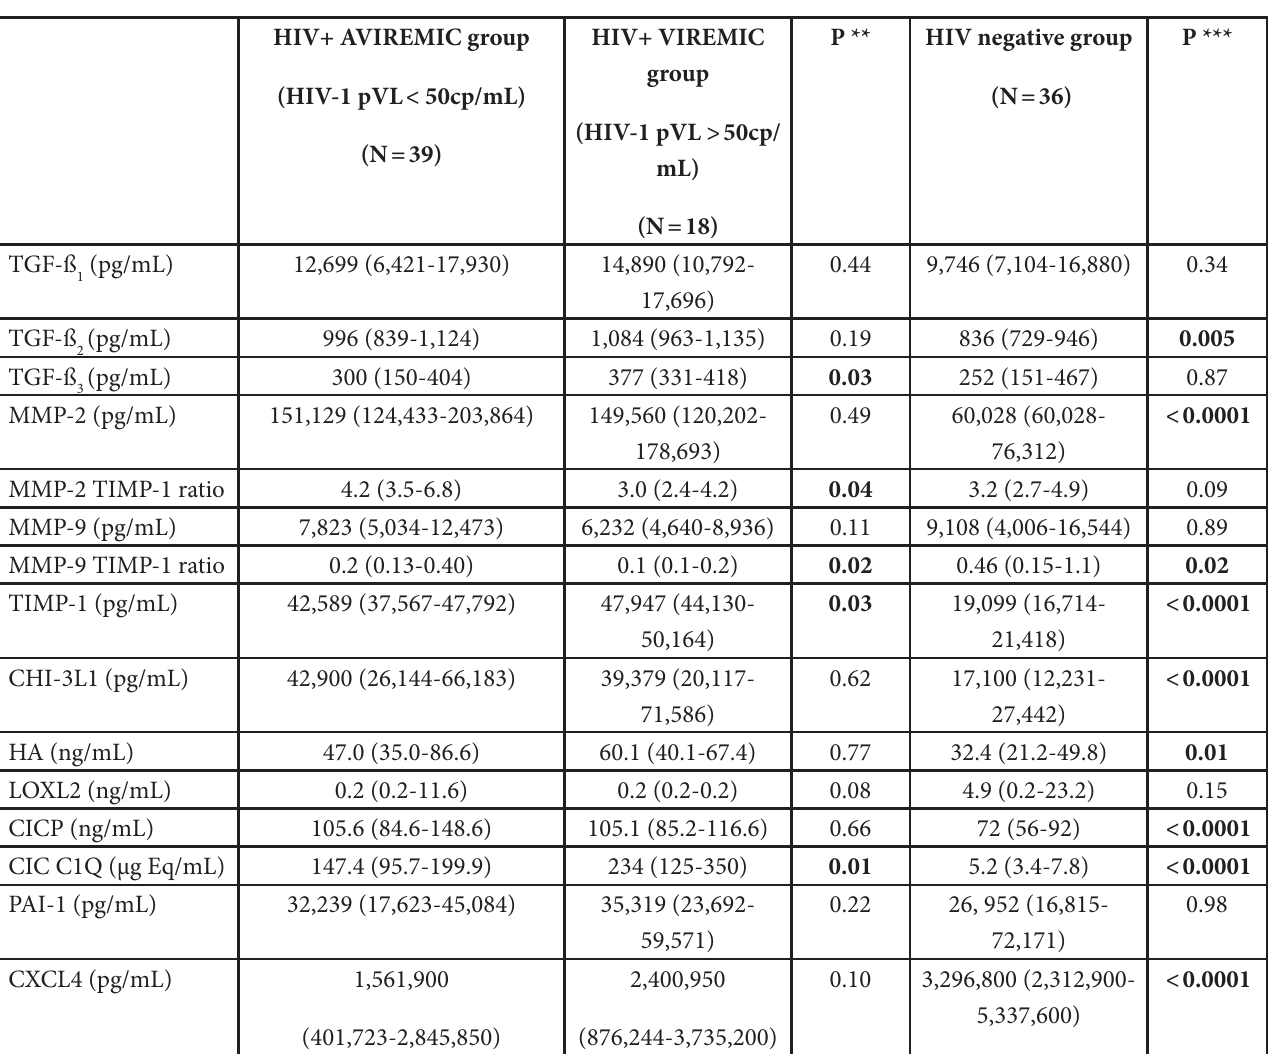
Table 3 : Circulating fibrosis biomarker levels overall among HIV infected and HIV uninfect- ed